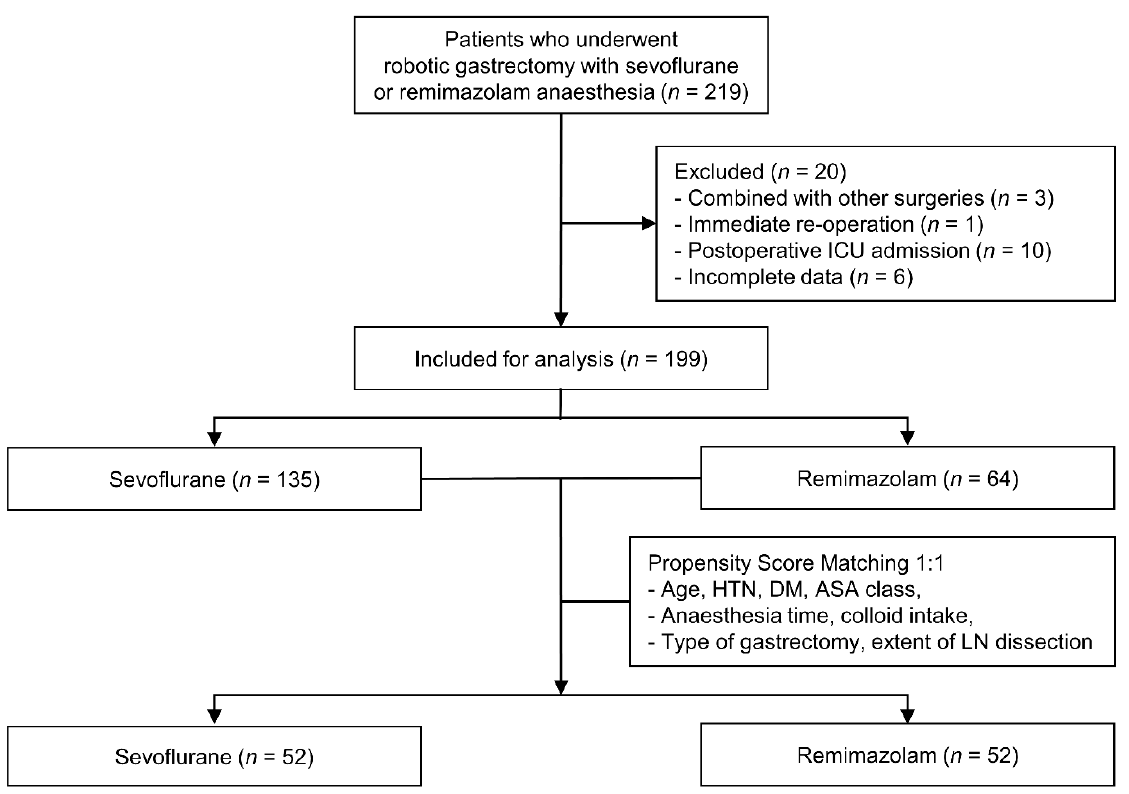
Figure 1. Flow diagram of the study. ICU, intensive care unit; HTN, hypertension; DM, diabetes mellitus; ASA, American Society of Anesthesiologists; LN, lymph node.